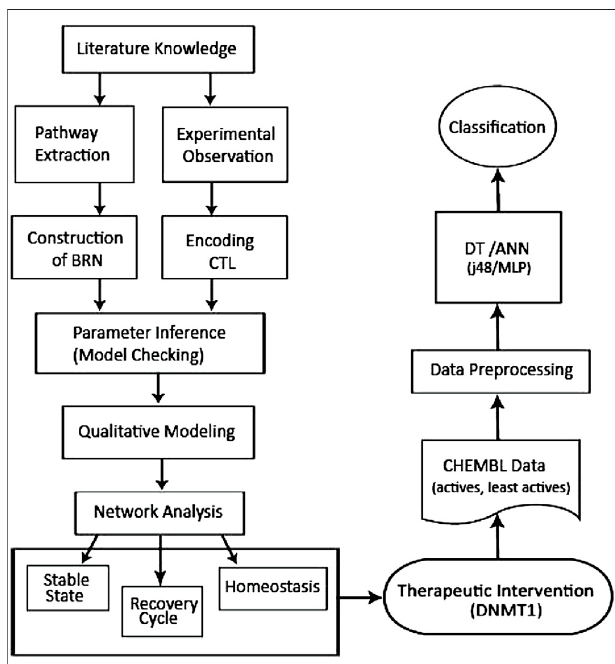
FIGURE 1 | Flowchart showing the overall methodology utilized in the current study. Qualitative modeling of the BRN to explore and model the DNMT1 – RUNX3 networkwasfollowedbytheapplicationofMLtechniquesto construct the predictive ML (DT and ANN) models using the DNMT1 data set extracted from the ChEMBL